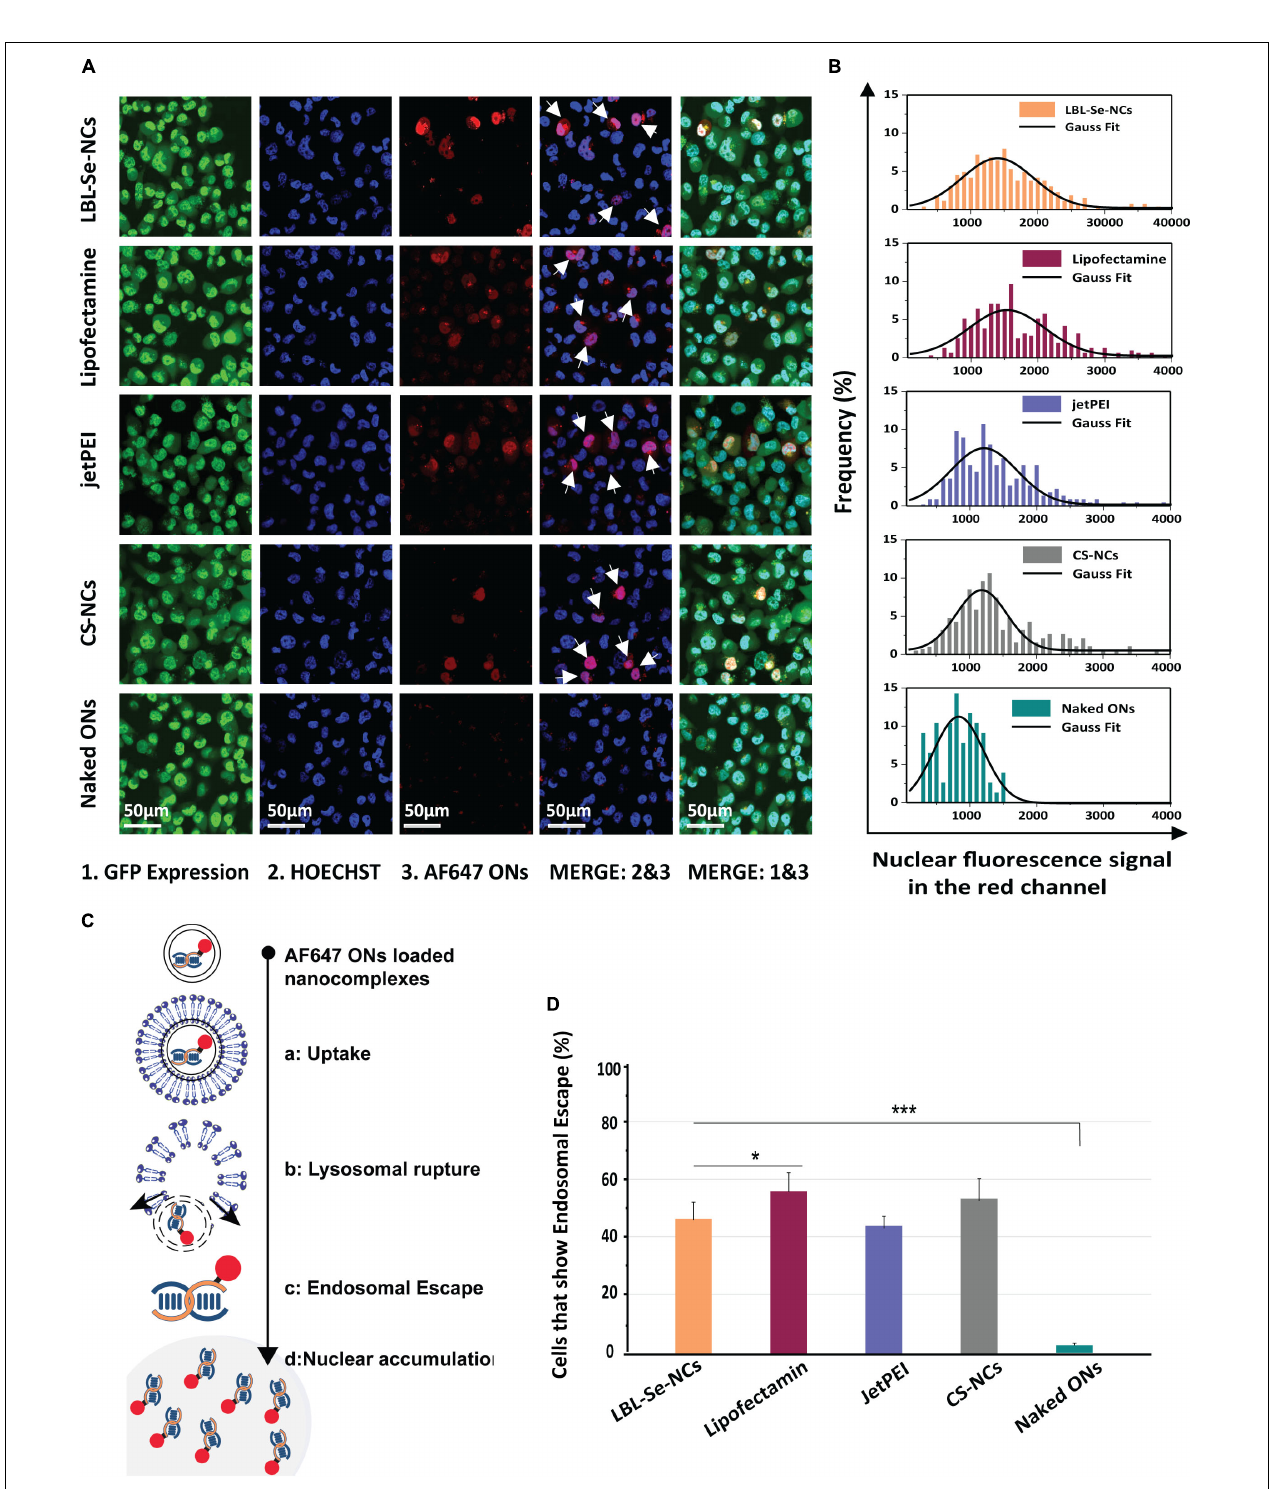
FIGURE 5 | Evaluation of Endosomal Escape based on AF647 ONs. (A) Representative confocal images 24 h post-incubation with AF647 ONs-loaded NCs in eGFP-H1299 cells. Upon endosomal escape, the labeled ONs which are loaded into the various nanocomplexes spread toward the cytoplasm, dequench, and finally accumulate into the nucleus. Hoechst nuclei can be seen in blue, while cells in which the endosomal escape occurred show nuclear fluorescence in the red channel (white arrows). The scale bar corresponds to 50 µ m. (B) The histogram of red fluorescent intensity of cell nuclei. (C) Scheme of ONs uptake, endosomal escape, and accumulation in the nucleus. (D) The percentage of cells that had at least one endosomal escape event as quantified from AF647 fluorescence of at least 250 nuclei. The scale bar corresponds to 50 µ m, ( n = 3, * p < 0.05; ** p < 0.01; *** p < 0.001).